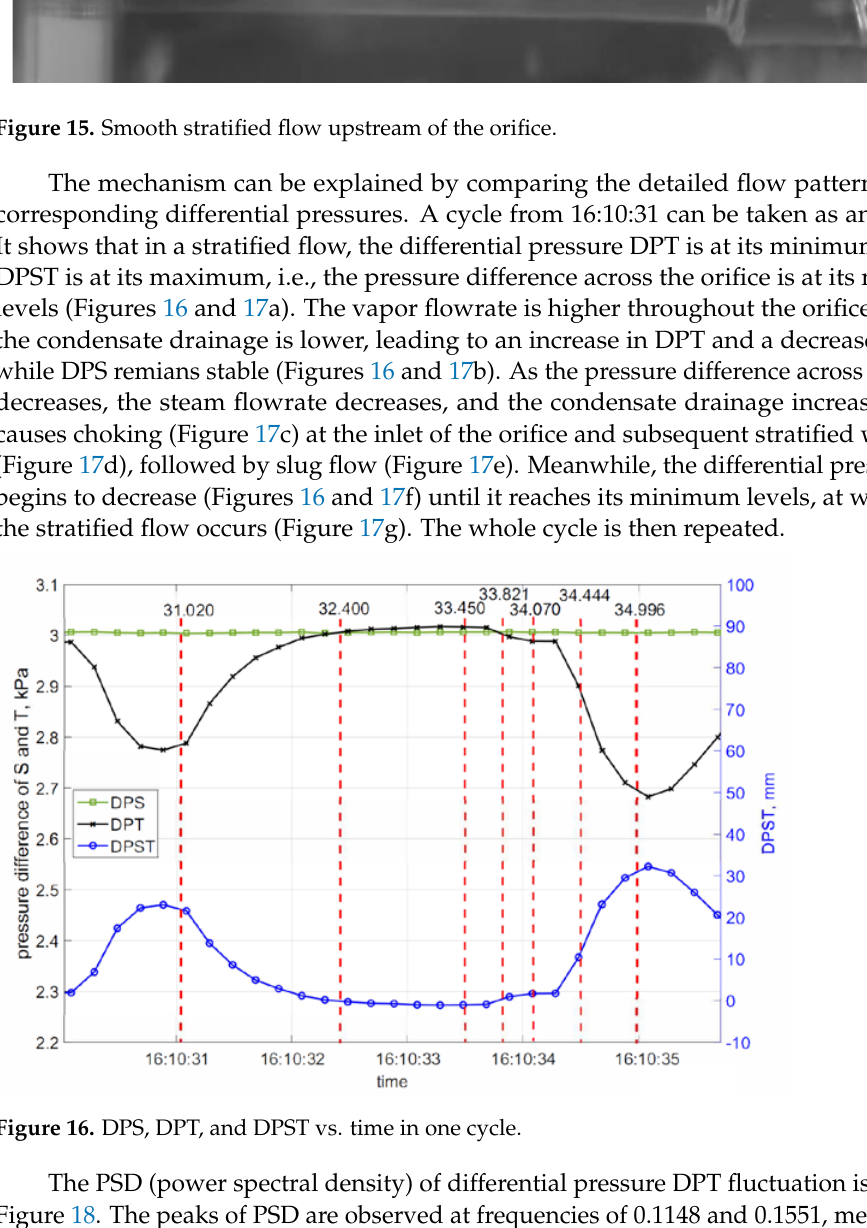
Figure 15. Smooth stratified flow upstream of the orifice.